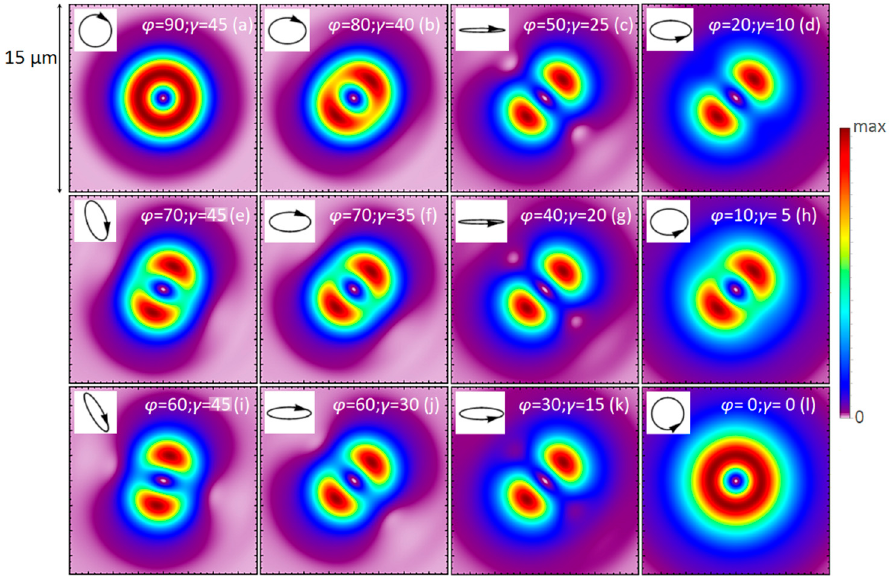
Figure 7. Intensity profile in the focal plane for variation 1 of the system, using the aspheric lens with lower numerical aperture. Variation 1A ( a ), variation 1C ( l ), and intermediate configurations ( b – k ). In Figure 7a–d,f–h,j–l, we represent the transition between variation 1A and 1C of the system resulting from the clockwise rotation of QWP by 10° and the clockwise rotation of HWP by 5°, which means φ = 2 γ ; cases φ = 70°, γ = 45° and φ = 60°, γ = 45° are represented in Figure 7e,i, respectively.